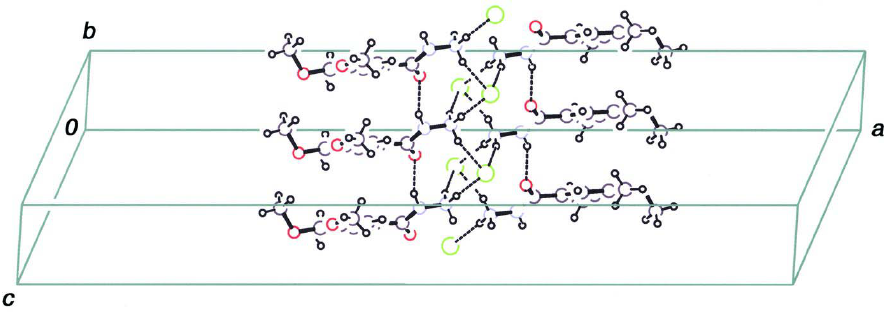
Figure 2 A partial packing diagram, showing the molecular tape running along the b axis. Hydrogen bonds are shown as dashed